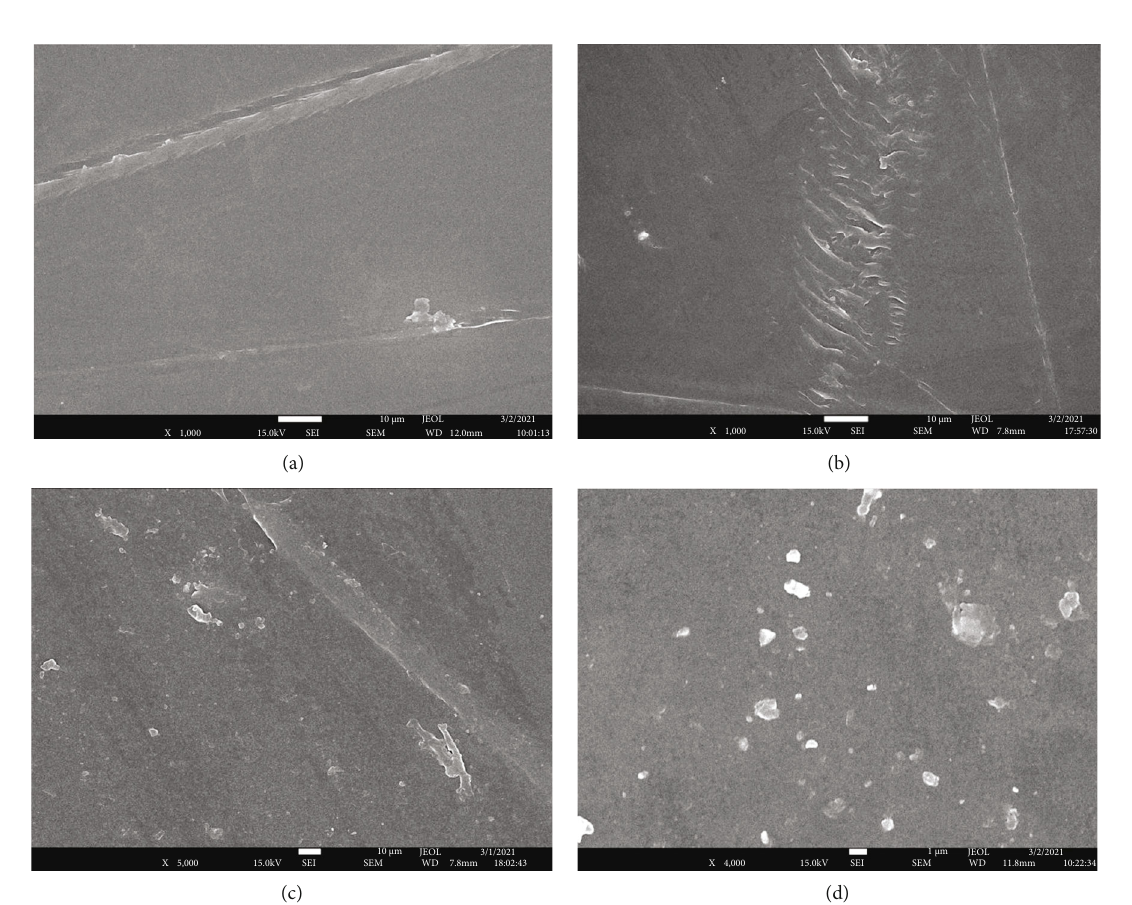
Figure 7: SEM images of the (a, b) active fi lm and (c, d) PS-based fi